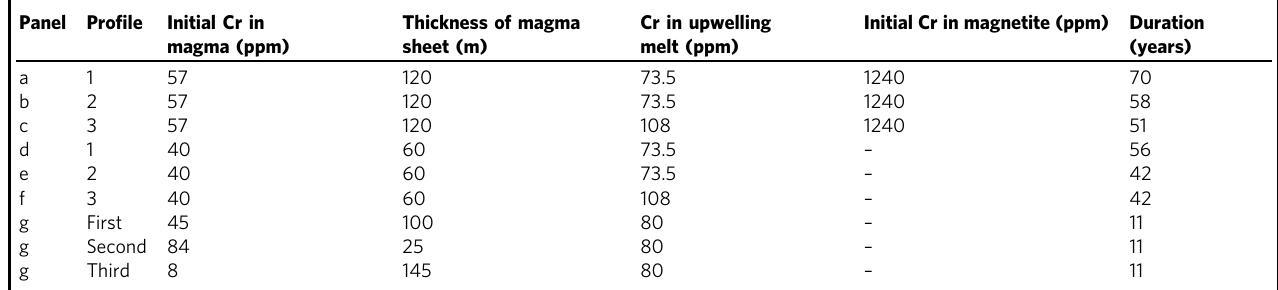
Table 1 Parameters for the fractional crystallization and reactive melt in fi ltration models. Panel Pro fi le Initial Cr in magma